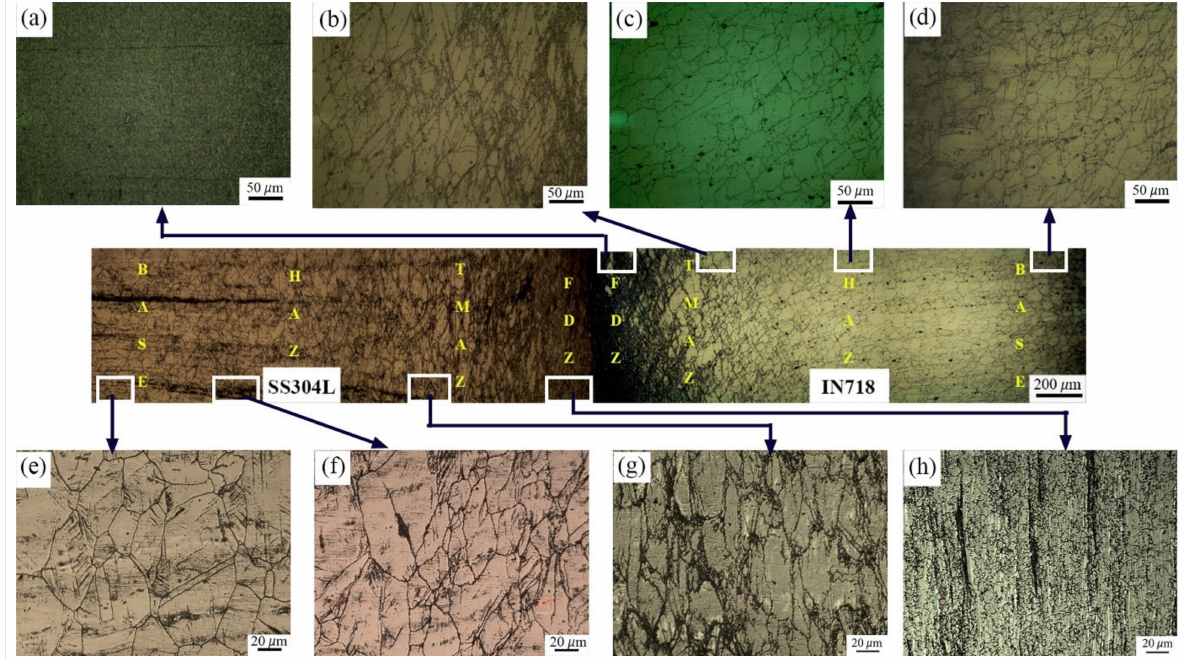
Figure 9. The optical microstructure of the SS304L/IN718 rotary friction welds in the as-welded, solution-treated, and aged conditions (SS304L/IN718 STA). IN718 side: ( a ) FDZ ( b ) TMAZ ( c ) HAZ ( d ) base metal; SS304L side: ( e ) base metal ( f ) HAZ ( g ) TMAZ ( h )